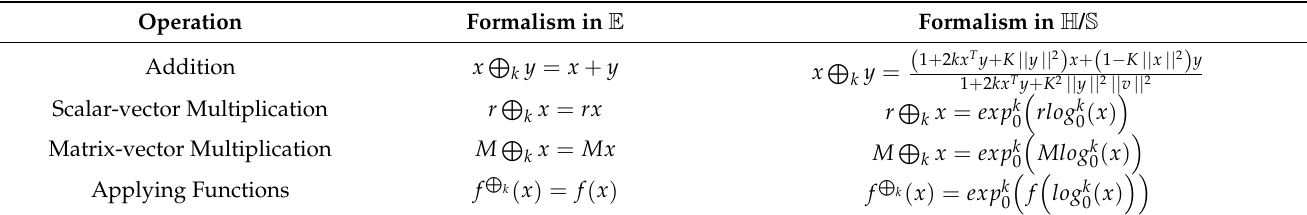
Table 4. Basic operation formulas in Riemann